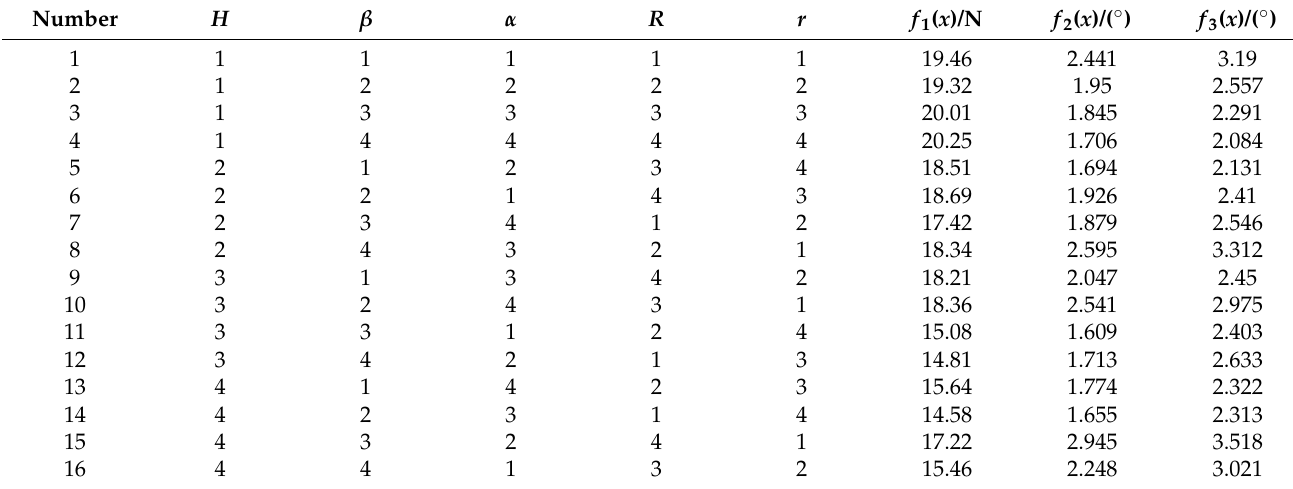
Table 5. Experimental layout and experimental